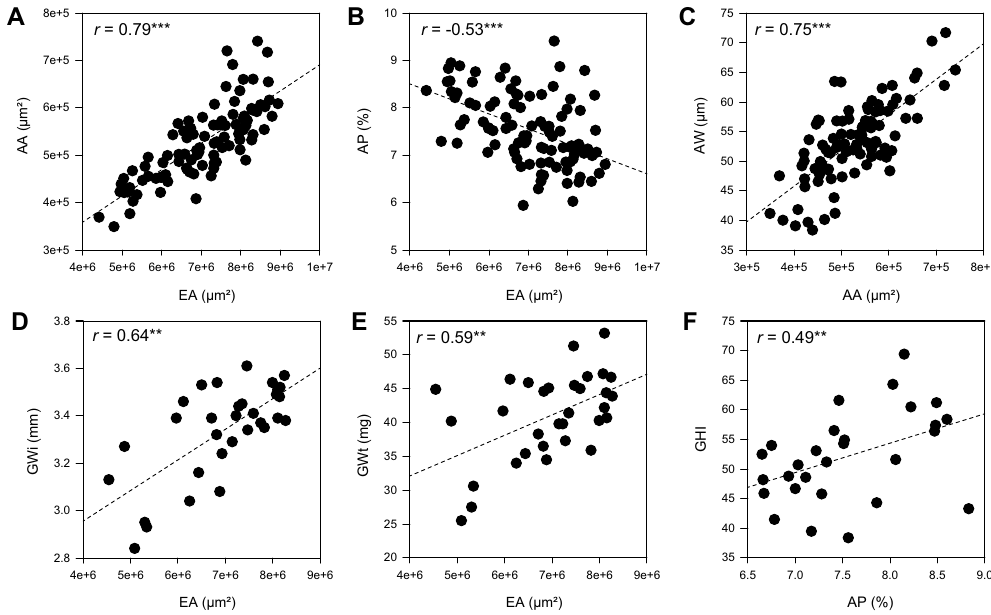
Figure 3. Transverse and wholegrain trait correlations across different barley genotypes. ( A – C ) Phenotypic measurements from all grain samples for 33 genotypes obtained using transverse grain sections. ( A ) Aleurone area vs endosperm area. ( B ) Aleurone proportion vs endosperm area. ( C ) Aleurone width vs aleurone area. ( D–F ) Correlations between grain measurements (averages) for all 2-row genotypes (n = 30) using the SeedCount, Single Kernel Characterisation System and/or transverse grain sections. ( D ) Grain width vs endosperm area. ( E ) Grain weight vs endosperm area. ( F ) Grain hardness index vs aleurone proportion. EA, Endosperm area; AA, aleurone area; AP, aleurone proportion; AW, aleurone width; GWi, grain width; GWt, grain weight. Significance indicators: *** p ≤ 0.001, ** p ≤ 0.01, * p ≤